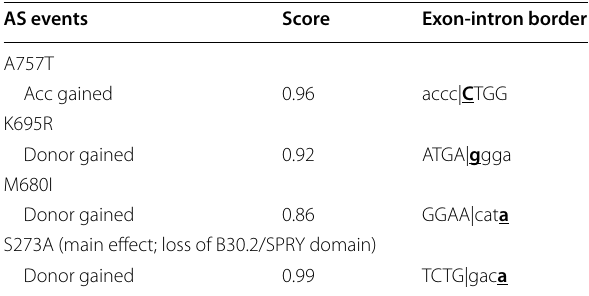
Table 3 Alternative splicing events due to some